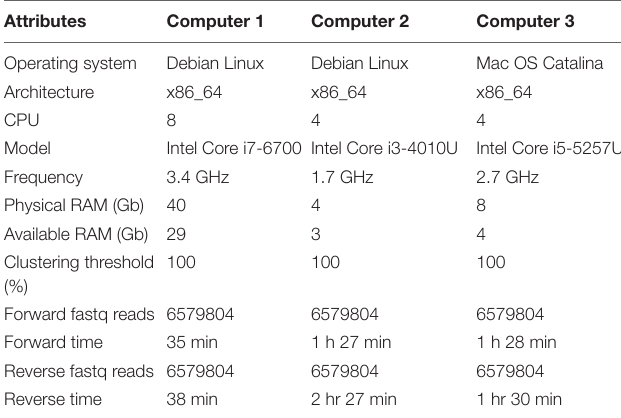
TABLE 2 | Specification of computers 1–3 and time required for analysis for the forward and reverse reads data generated in this